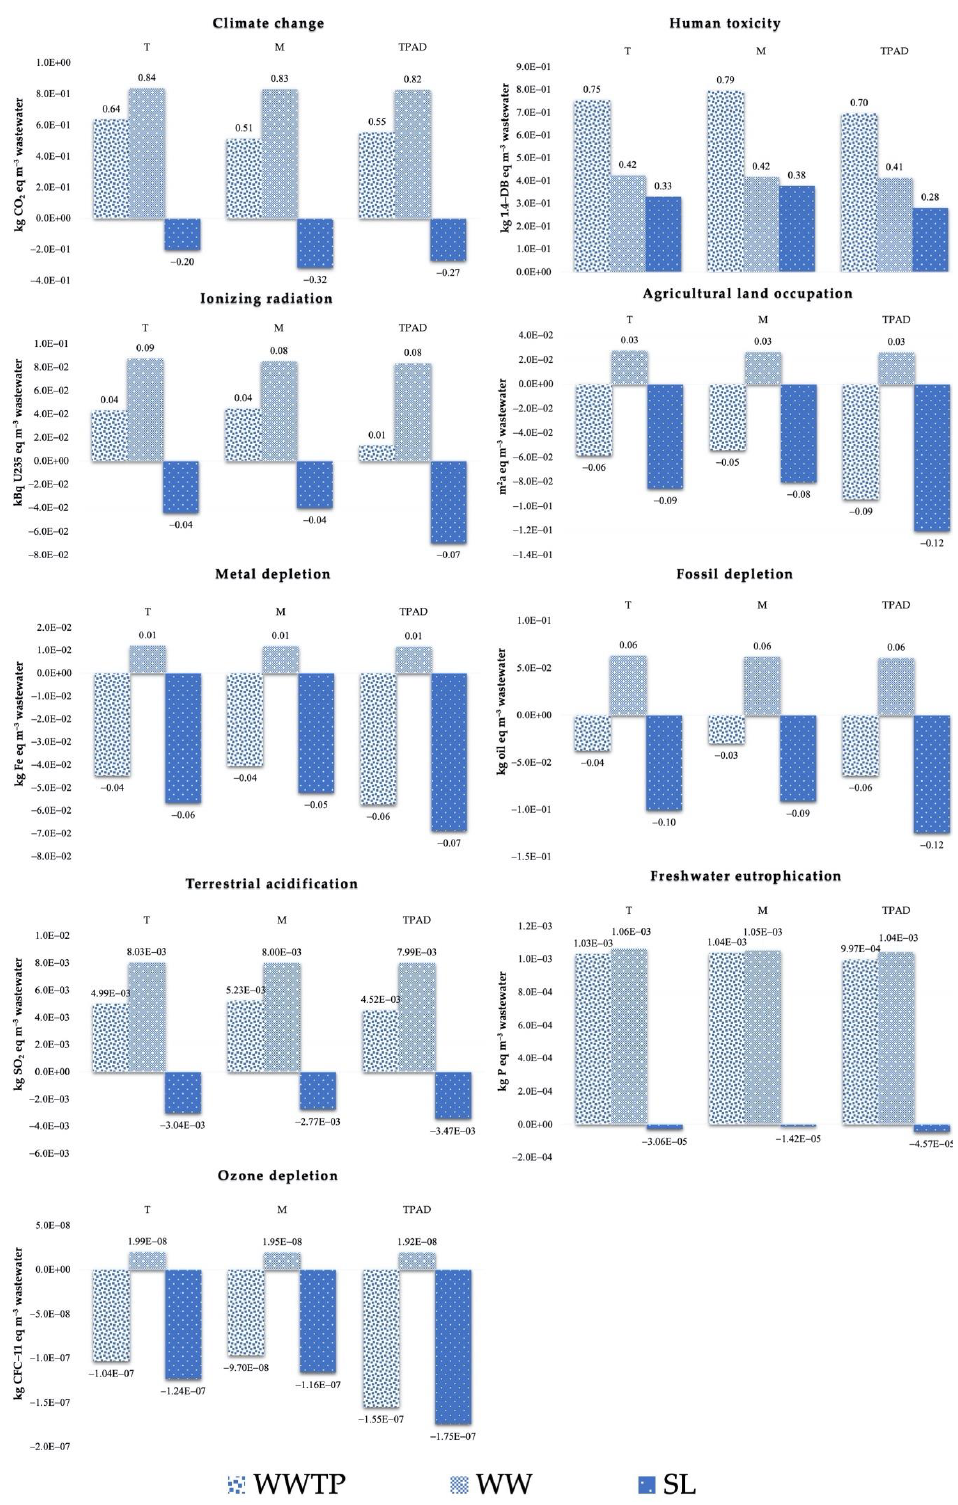
Figure 2. Potential environmental impacts for the three scenarios of the whole WWTP (WWTP-LCA): Mesophilic (M), Thermophilic (T), and Temperature-Phased Anaerobic Digestion (TPAD). WWTP: wastewater treatment plant; WW: wastewater line; SL: sludge line. Results shown for the FU: 1 m 3 of treated